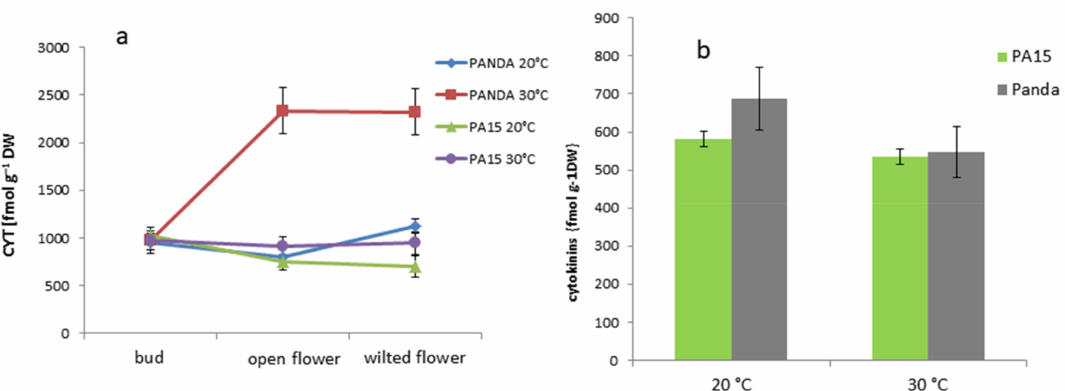
Figure 4. Content of cytokinins (CYT; zeatin and kinetin) [fmol g − 1 DW] in the flower buds, open flowers, and wilted flowers ( a ) and the leaves ( b ) of the ‘Panda’ and PA15 plants grown at 20 ◦ C (control) and 30 ◦ C (thermal stress). Means ( n = 3) ± SE.